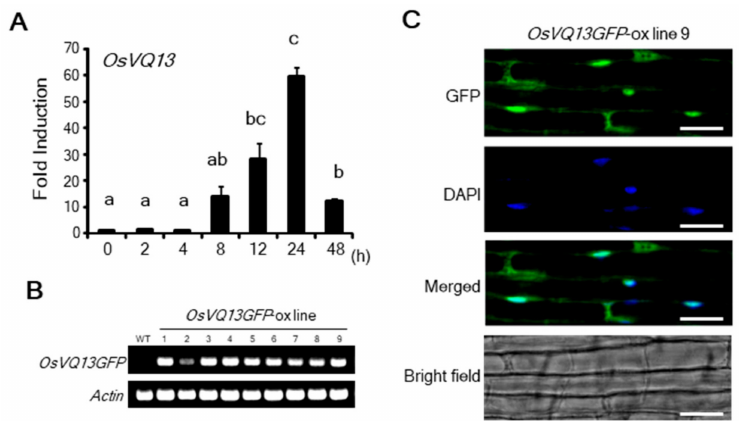
Figure 1. Jasmonic acid (JA)-induced expression and subcellular localization of OsVQ13. ( A ) Expression levels of OsVQ13 in response to JA. Total RNA was extracted at the indicated time points after 100 µ M of JA